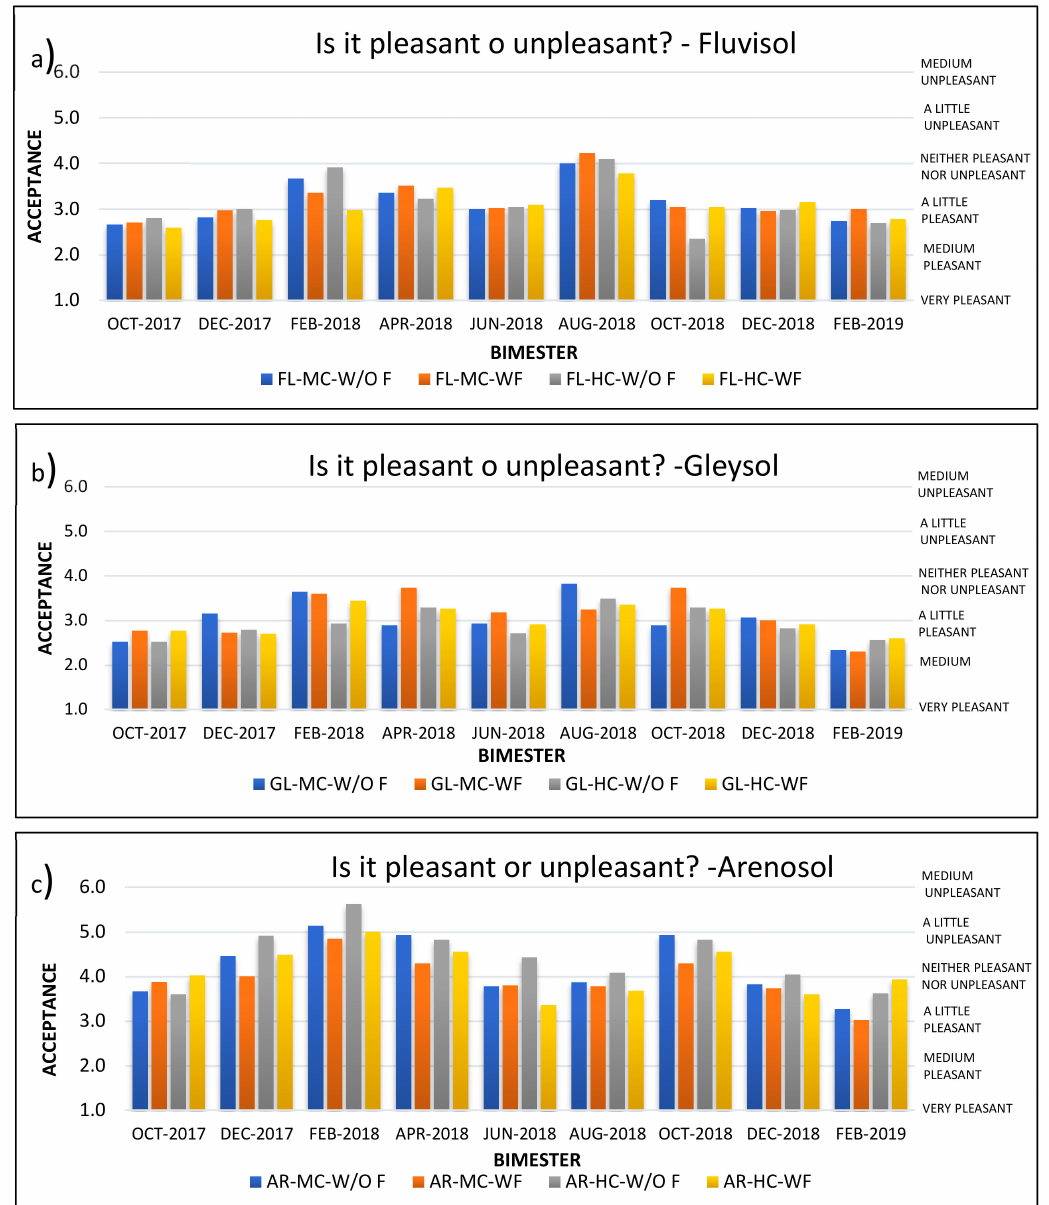
Figure 3. Acceptance level for odor in soil. a ) In Fluvisol, b ) in Gleysol, c ) in Arenosol. Values are averages of three replicates. FL = Fluvisol; GL = Gleysol; AR = Arenosol; MC = Medium Crude Oil; HC = Heavy Crude Oil; W / O F = Without Fertilizer; WF = With